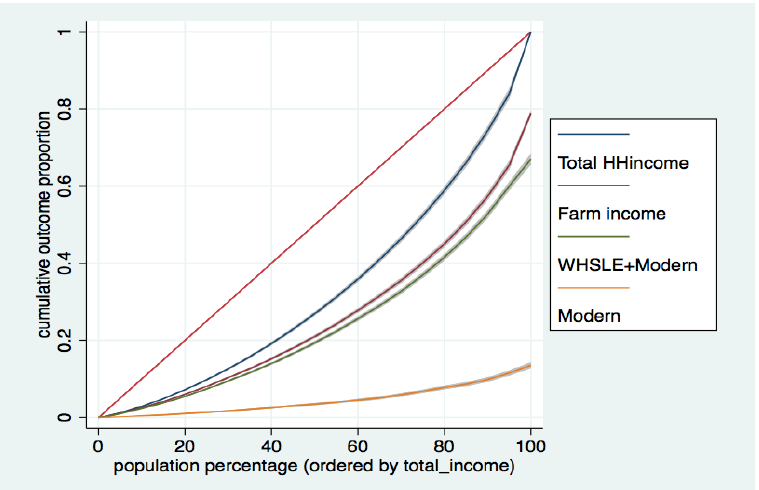
Figure 1. Lorenz curve.